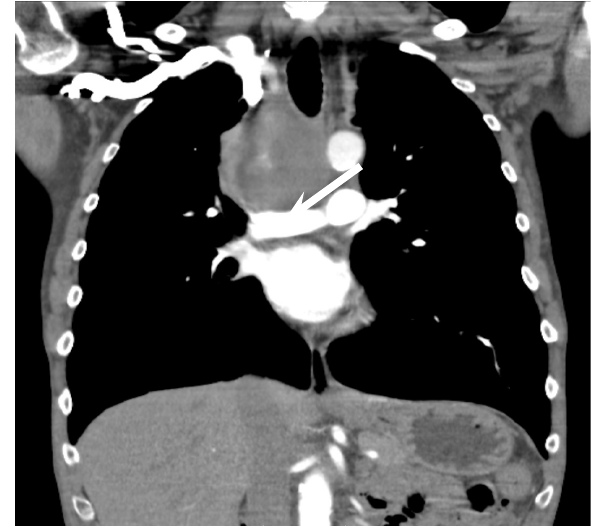
Figure 2 . Coronal computed tomography of paratracheal mass with right anterolateral trachaeal involvement.